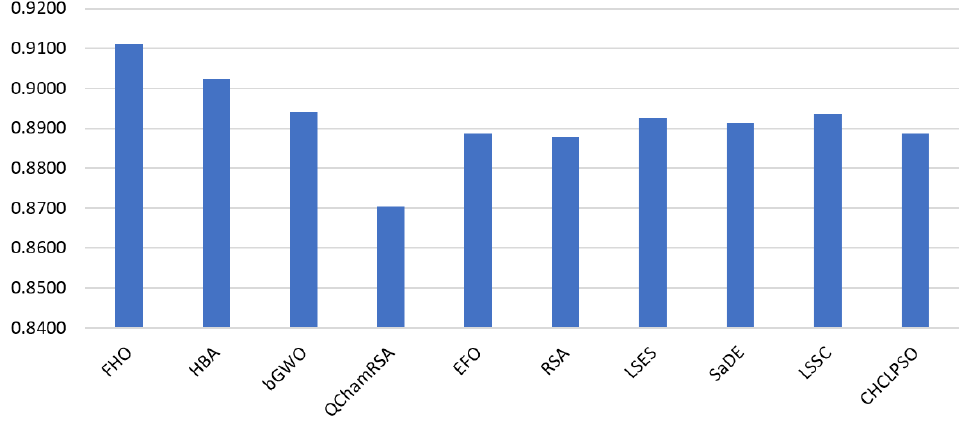
Figure 2. Average of the accuracy measure in the binary case.